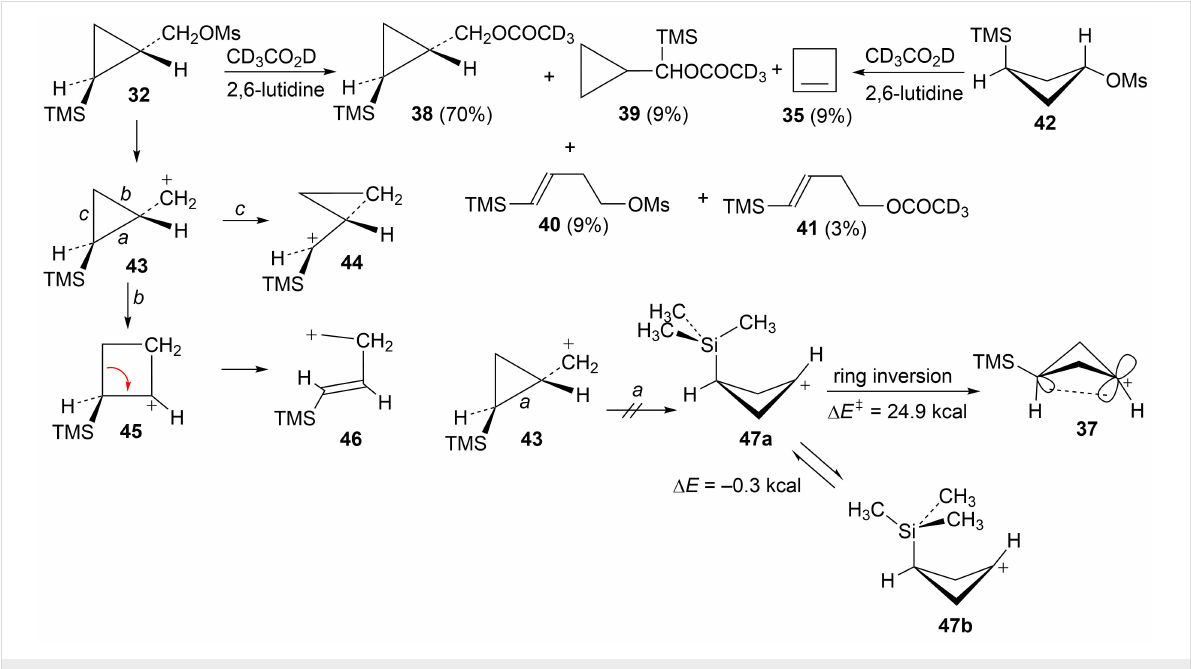
Scheme 9: Reaction of mesylate 32 in CD 3 CO 2 D.